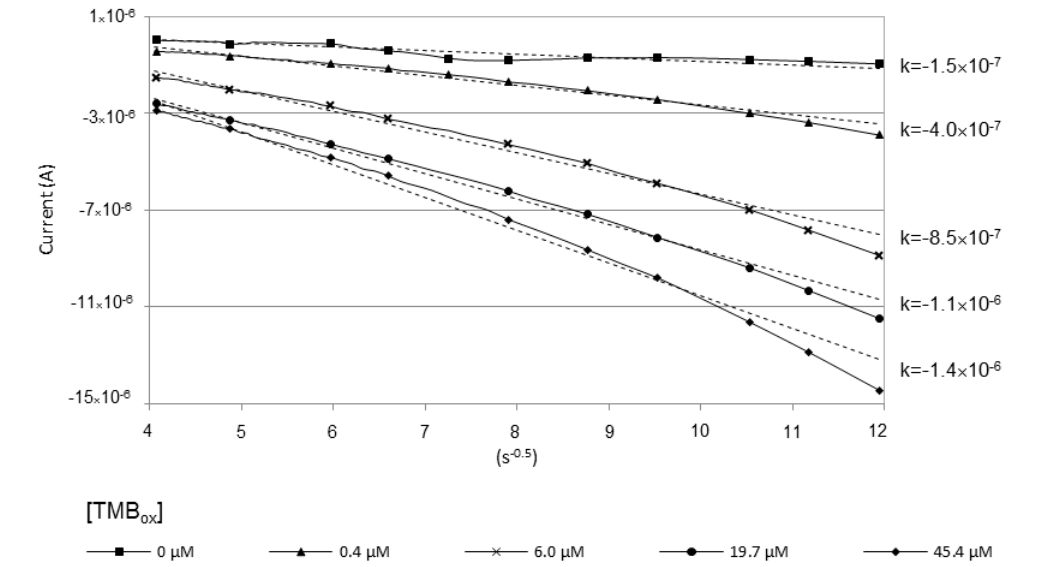
Figure 4. Experimental Results. The measured current is plotted against the inverse root of time and linear regression lines are calculated.